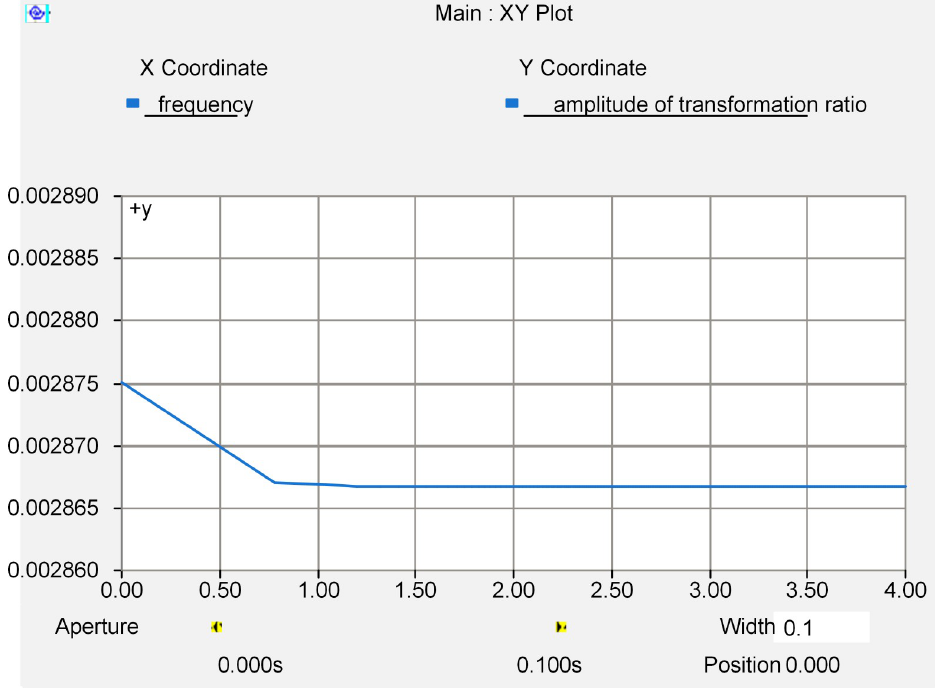
Fig 11. Amplitude-frequency response of the RCVT transformation ratio.